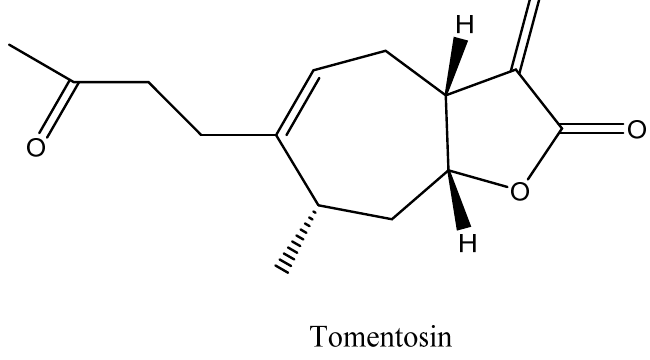
Figure 1. Chemical structure of Tomentosin.